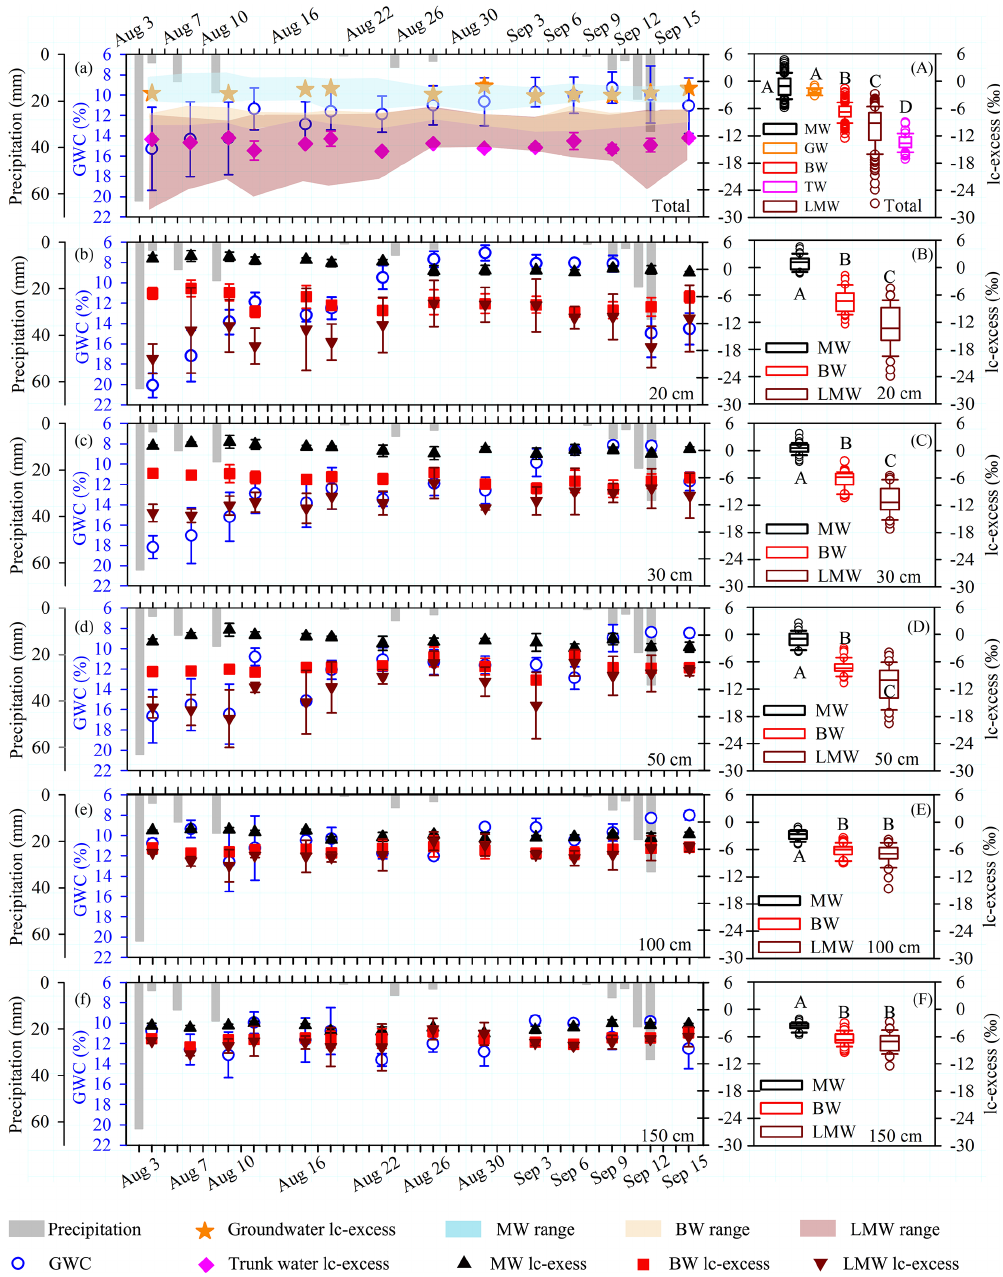
Figure 3. (a–f) Temporal dynamics of hydrological conditions (precipitation and gravimetric water content, GWC) and lc-excess values (these values are means and standard deviations based on three sites) of groundwater (GW), trunk water (TW), mobile water (MW), bulk soil water (BW) and less mobile water (LMW) at the indicated depths (20, 30, 50, 100 and 150cm) during the period 3 August to 15 Septem- ber 2019. (A) Boxplots of total MW ( N = 191), GW ( N = 22), BW ( N = 204), TW ( N = 61) and LMW ( N = 176) lc-excess values. (B–F) Boxplots of MW and BW at depths of 20cm (MW, N = 40; BW, N = 42; LMW, N = 39), 30cm (MW, N = 40; BW, N = 40; LMW, N = 34), 50cm (MW, N = 38; BW, N = 40; LMW, N = 33), 100cm (MW, N = 36; BW, N = 40; LMW, N = 34) and 150cm (MW, N = 37; BW, N = 42; LMW, N = 36). The top and bottom of each box are the 25th and 75th percentiles of the samples, respectively. The black line in each box is the sample median. Trunk water and potential water sources that do not share a letter are significantly different ( p< 0 . 05, Tukey–Kramer